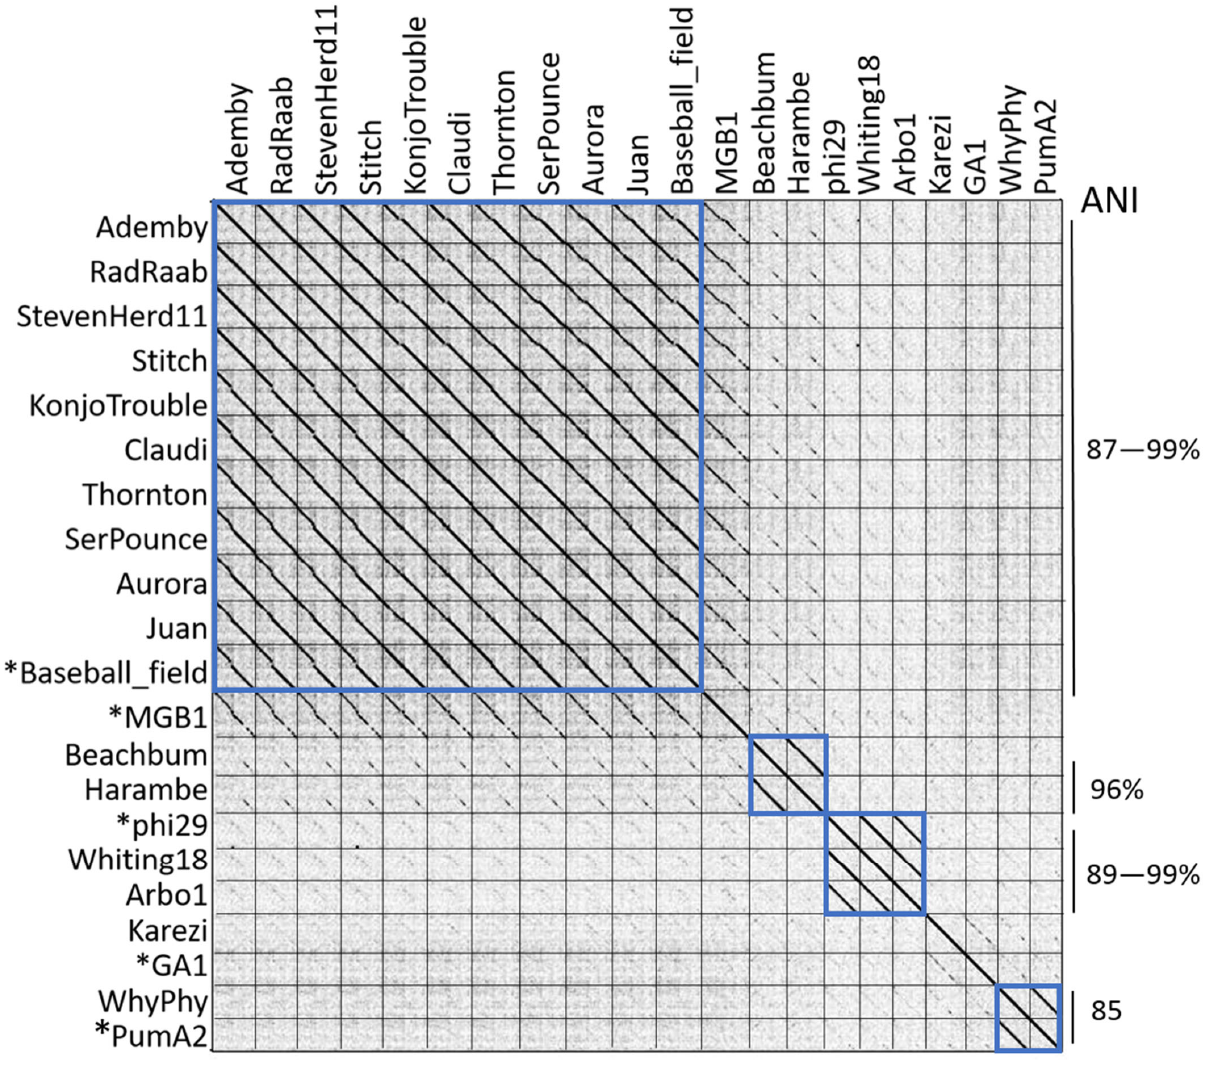
Figure 2. Whole genome sequence comparison by dotplot. Concatenated whole genome sequences were compared to visualize genome identity by dotplot. Blue boxes represent genome groupings. Lines on the right indicate groupings of similar genomes labeled with average nucleotide identity values. An asterisk indicates genomes obtained from GenBank.